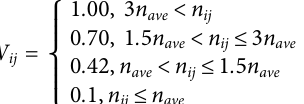
Frontiers in Environmental Science |